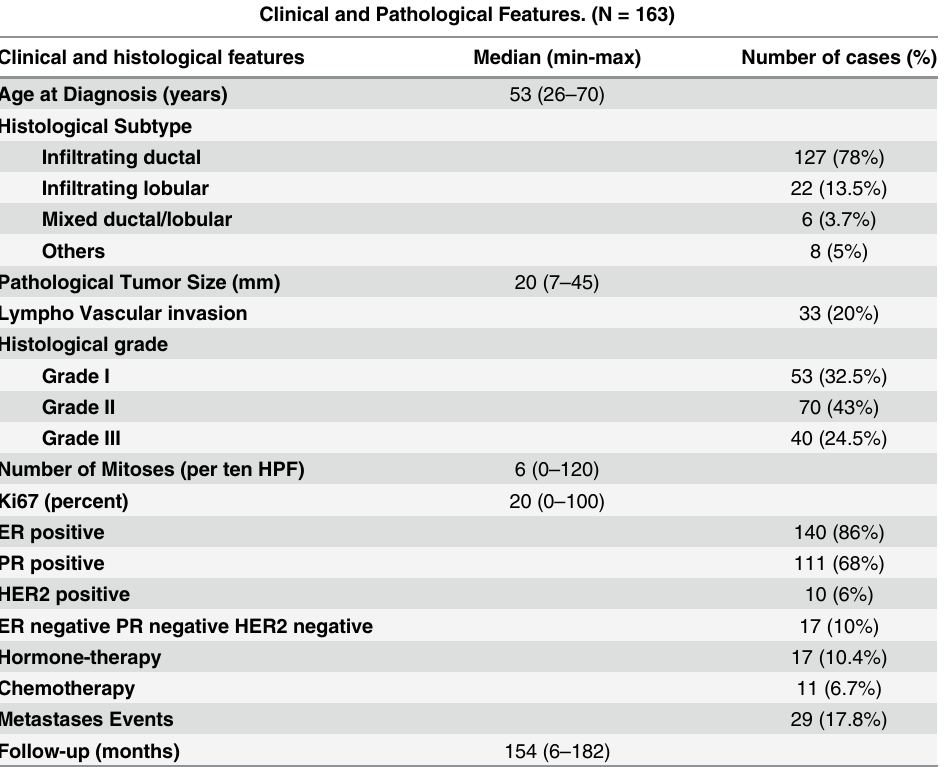
Table 1. Clinical and pathological features of 163 invasive early-stage breast carcinoma. Clinical and Pathological Features. (N =